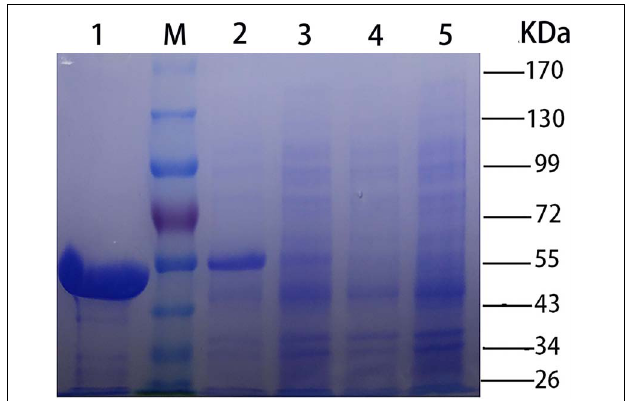
FIGURE 2 | SDS-PAGE [stacking gel (5%, w/v) and separating gel (10%, w/v)] analysis of CHAO YT − 02 . Lanes: M, molecular standard; 1, purified recombinant CHAO YT − 02 ; 2, E. coli BL21 (DE3) harboring pET-28b- chao after induction; 3, E. coli BL21 (DE3) harboring pET-28b- chao without induction; 4, E. coli BL21 (DE3) harboring pET-28b without induction; 5, E. coli BL21 (DE3) harboring pET-28b after induction.